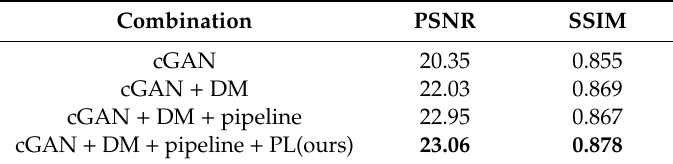
Table 3. Quantitative evaluation of the e ff ects of di ff erent components in the